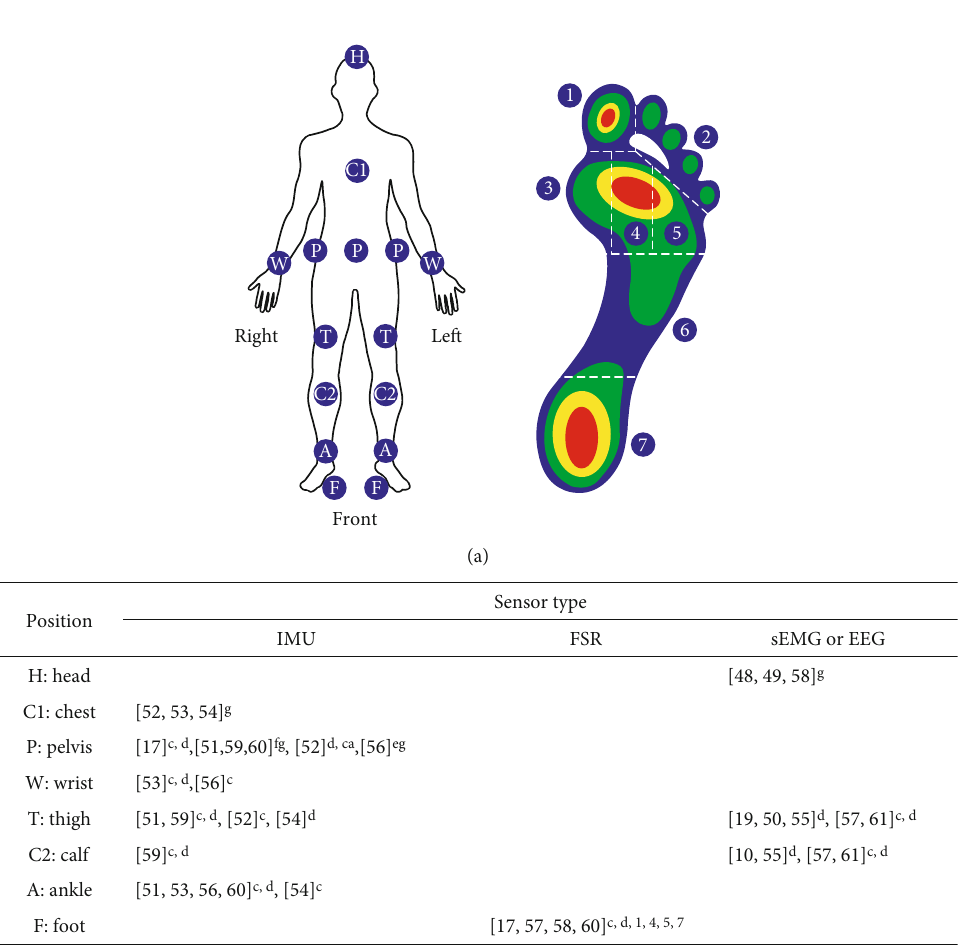
Figure 4: Sensor positions [10, 17, 19, 48 – 61]. (a) Typical attachment positions of multiple sensors. (b) Type and location of the sensors applied in the papers (IMU: inertial measurement unit; FSR: force sensitive resistor; sEMG: surface electromyography, EEG: electroencephalography; MPJ: metatarsophalangeal